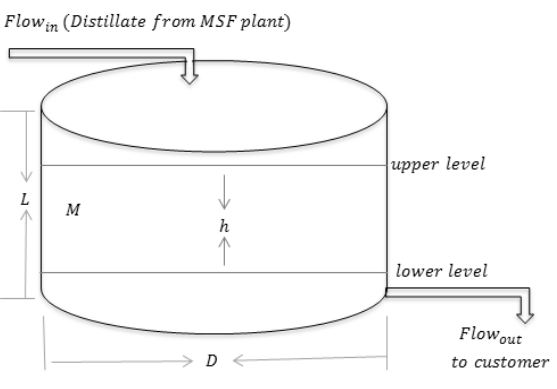
Figure 4. Storage